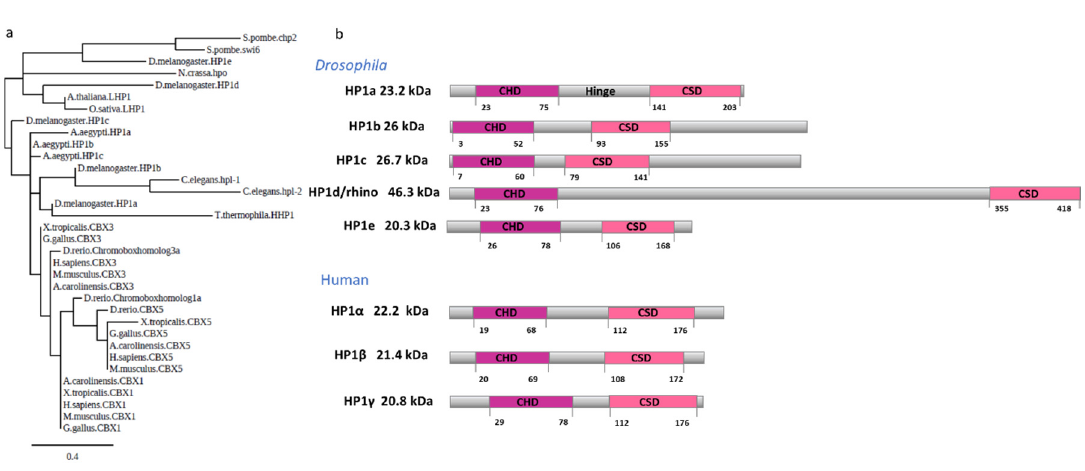
Figure 2. HP1 is preserved during evolution. ( a ) Maximum likelihood phylogenetic analysis of the HP1 protein information of the containing proteins as computed by PhyML. The amino acid sequences were analyzed from the following organisms: Tetrahymena thermophila , Schizosaccharomyces pombe , Neurospora crassa , Arabidopsis thaliana , Oryza sativa , Caenorhabditis elegans , Aedes aegypti , Drosophila melanogaster , Xenopus tropicalis , Anolis carolinensis , Danio rerio , Gallus gallus , Mus musculus , and Homo sapiens . ( b ) Diagram of HP1 proteins in Drosophila and humans. The chromodomain is shown in magenta, and the chromoshadow is in rose. The molecular weight is indicated to the left, with the amino acid localization of the domains displayed below each protein.